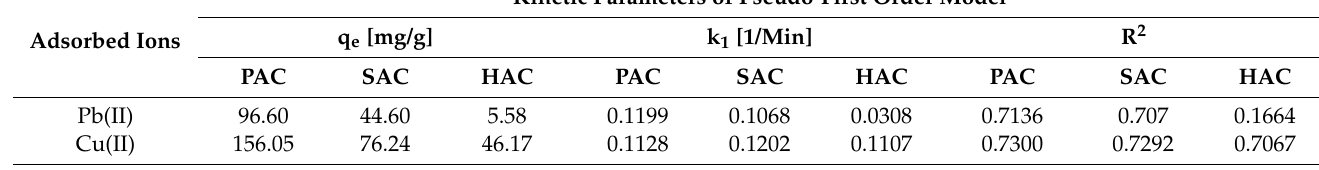
Figure 4. Adsorption kinetics of Pb(II) and Cu(II) ions on the examined solids surface; C 0 = 200 mg/dm 3 , pH 5. Table 4. Kinetic parameters obtained for modelling of heavy metal ions adsorption on the examined solids surface; C 0 = 200 mg/dm 3 ppm, pH 5.